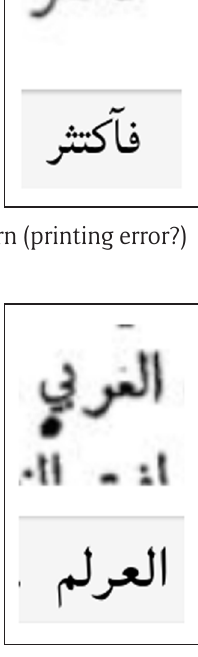
Figure 14: Atypical dot/letter placement and poor scan quality.